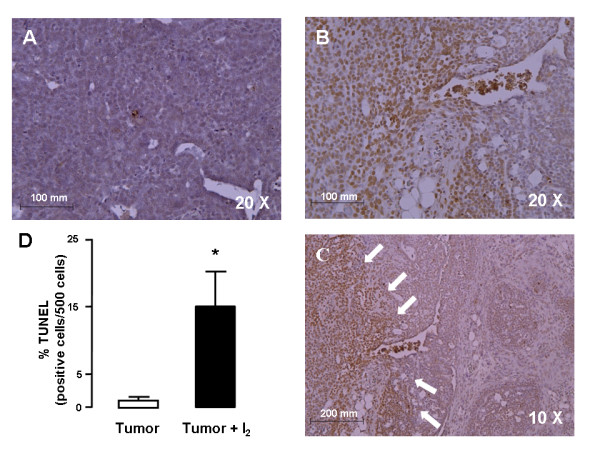
Apoptotic rate. Representative sections of TUNEL-positive cells in tumors from control (A) or I2-treated rats (B), magnification 20×. C, Section of rat tumor treated with I2 that shows an extensive zone of TUNEL-positive cells (white arrows), magnification 10×. TUNEL-positive cells were revealed with diaminobenzidine (brown stain) and counterstained with hematoxylin (purple stain). D, TUNEL-positive cell quantification. The difference between experimental groups was analyzed using an unpaired t test. *indicates significant difference from the control (p < 0.05)